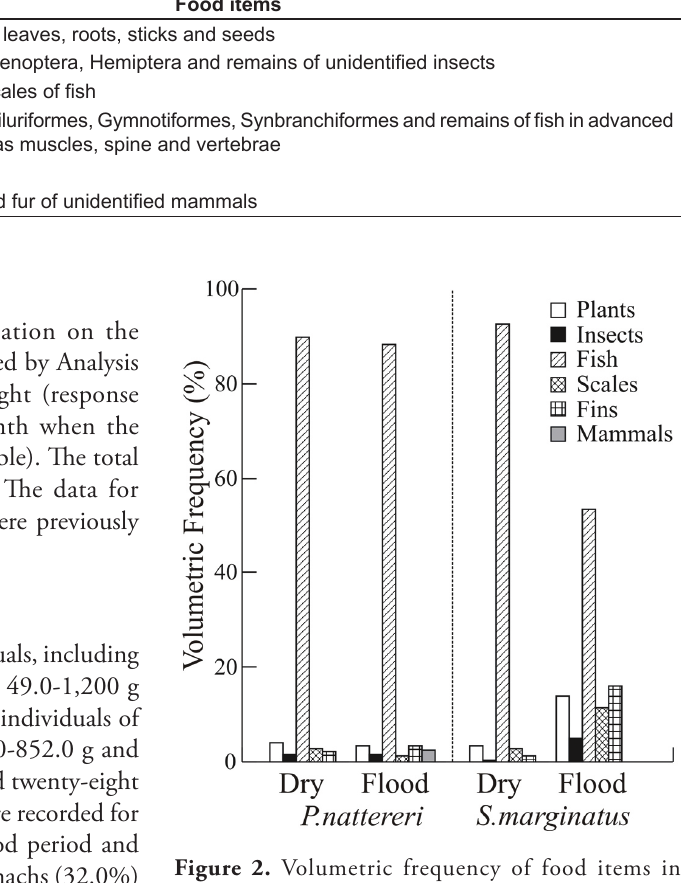
Table 1. Categories and food items recorded in the diets of Pygocentrus nattereri and Serrasalmus marginatus. Categories